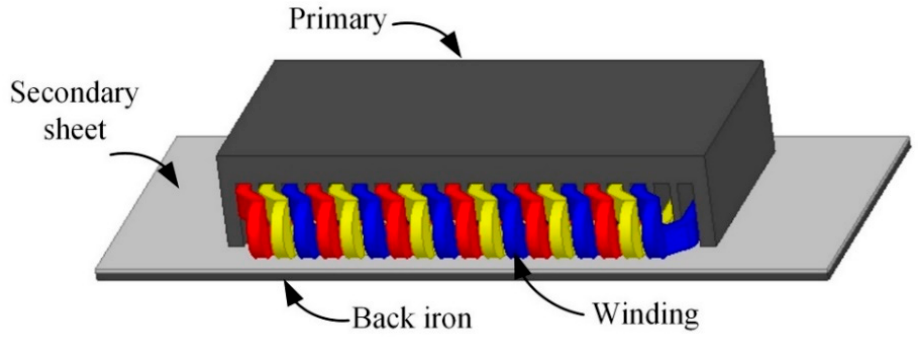
Figure 1. The structure of a single-sided linear induction motor (SLIM) 2. Materials and Methods. Figure 2 shows the gradual increase and sudden decrease of the normalized air-gap flux density versus time.